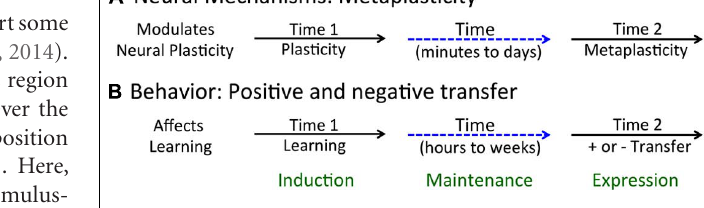
FIGURE 1 |Acute and long-term effects of neurobiological and behavioral processes. (A) Metaplasticity arises when an initial event (at Time 1) brings about a lasting change in neural function that affects plastic potential (atTime 2). (B) Learning can affect the future capacity to learn, enhancing learning about new events and relations (positive transfer) or inhibiting this process (negative